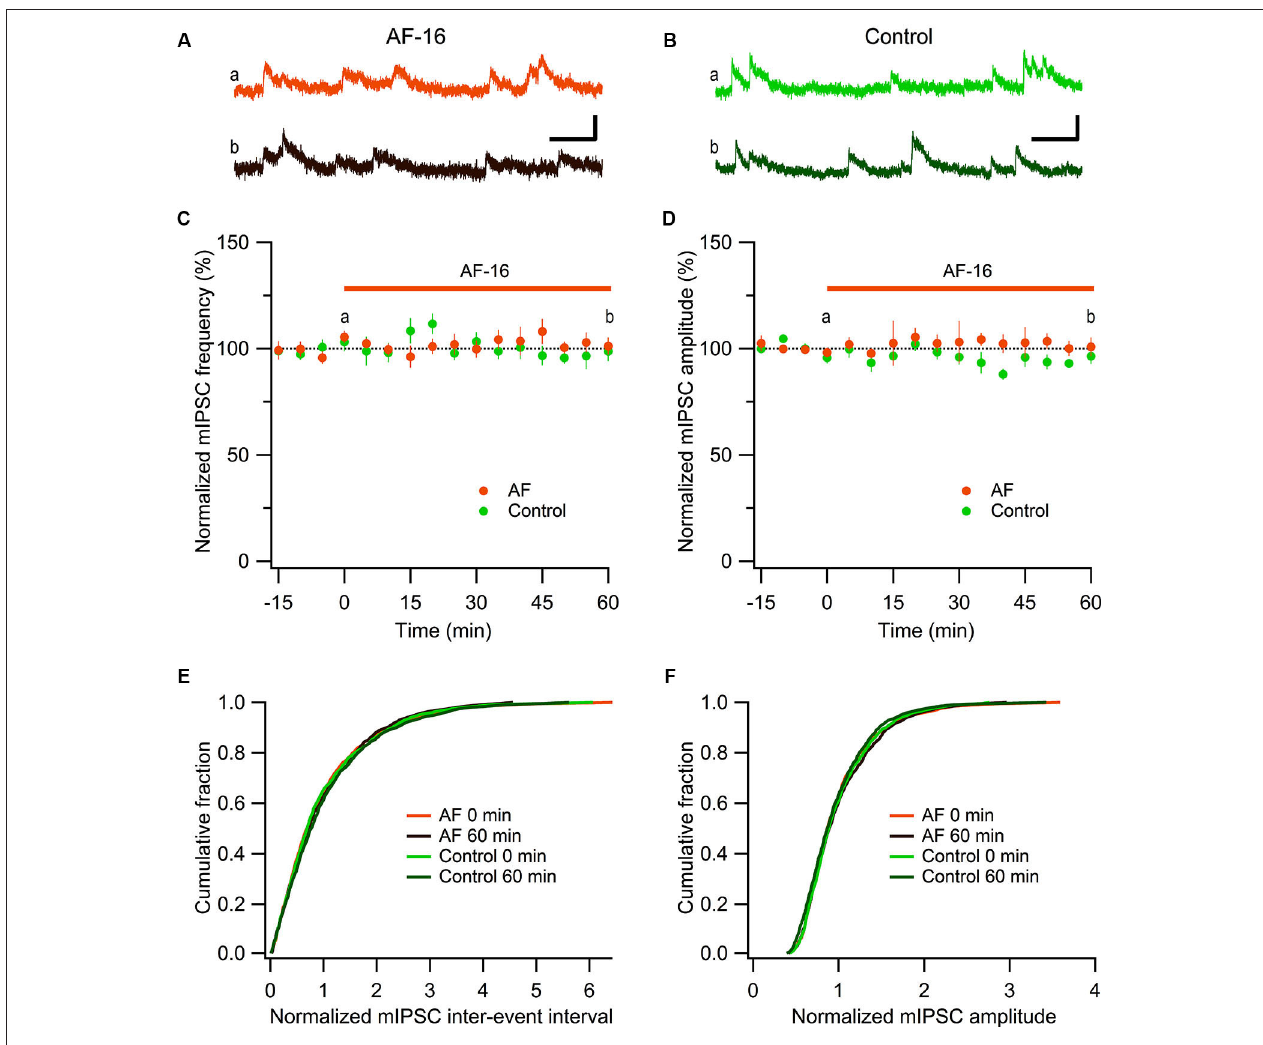
frequencies of recorded mIPSCs in CA1 pyramidal neurons exposed to AF-16 ( n = 6) and controls not exposed to AF-16 ( n = 7). (D) Summary graph of average ( ± s.e.m.) amplitudes of recorded mIPSCs in CA1 pyramidal neurons exposed to AF-16 ( n = 6) and controls ( n = 7). (E) Cumulative distributions of mIPSC inter-event intervals at 0 min and 60 min after AF-16 application ( n = 6) and control ( n = 7). (F) Cumulative distributions of mIPSC amplitudes at 0 min and 60 min after AF-16 application ( n = 6) and control ( n =